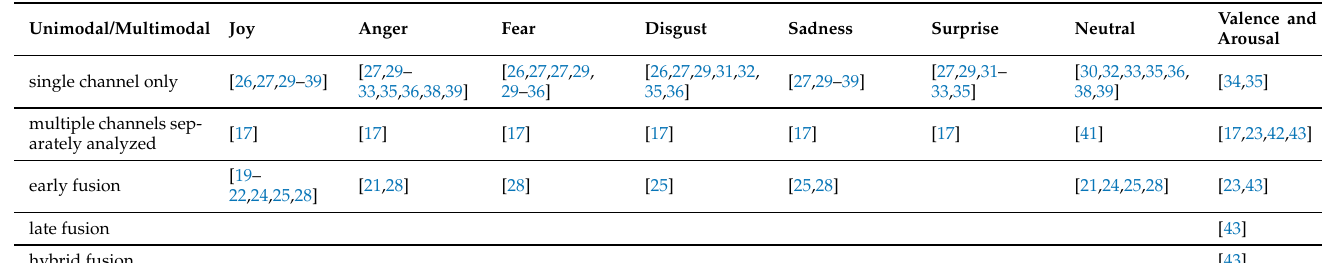
Table 10. Analysis of modalities versus recognized emotions in the Ekman and Russel models.